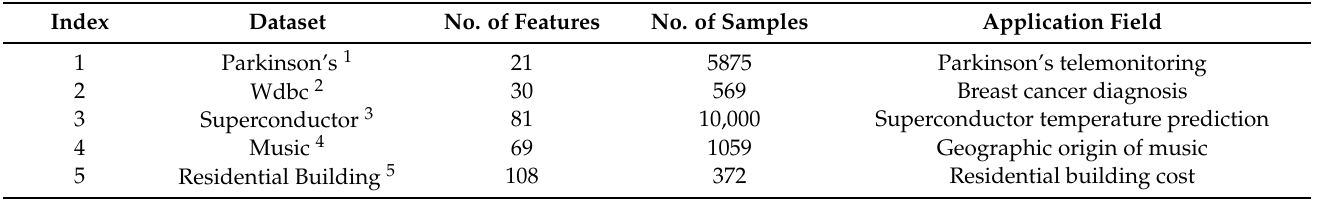
Table 1. Summary of the five regression